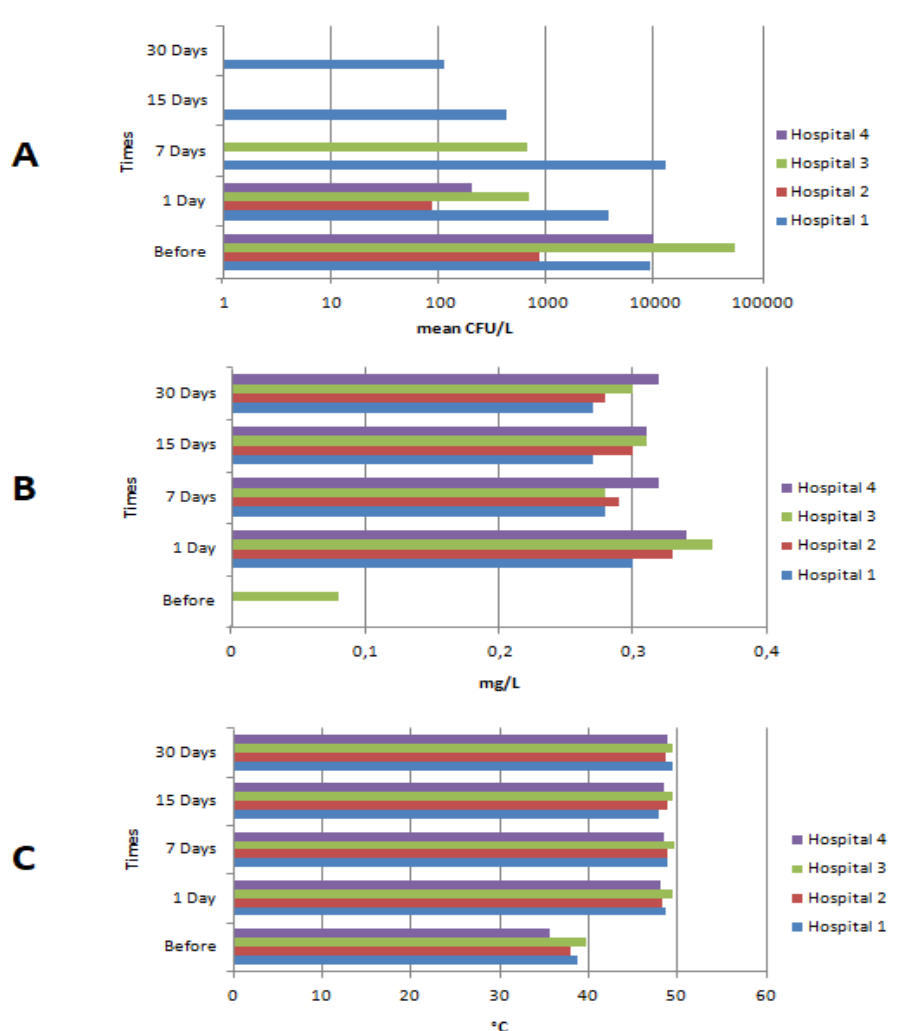
Figure 5. Legionella pneumophila counts (CFU/L) ( A ), total chlorine concentration (mg/L) ( B ), and temperature values (°C) ( C ) detected in all the hospitals.